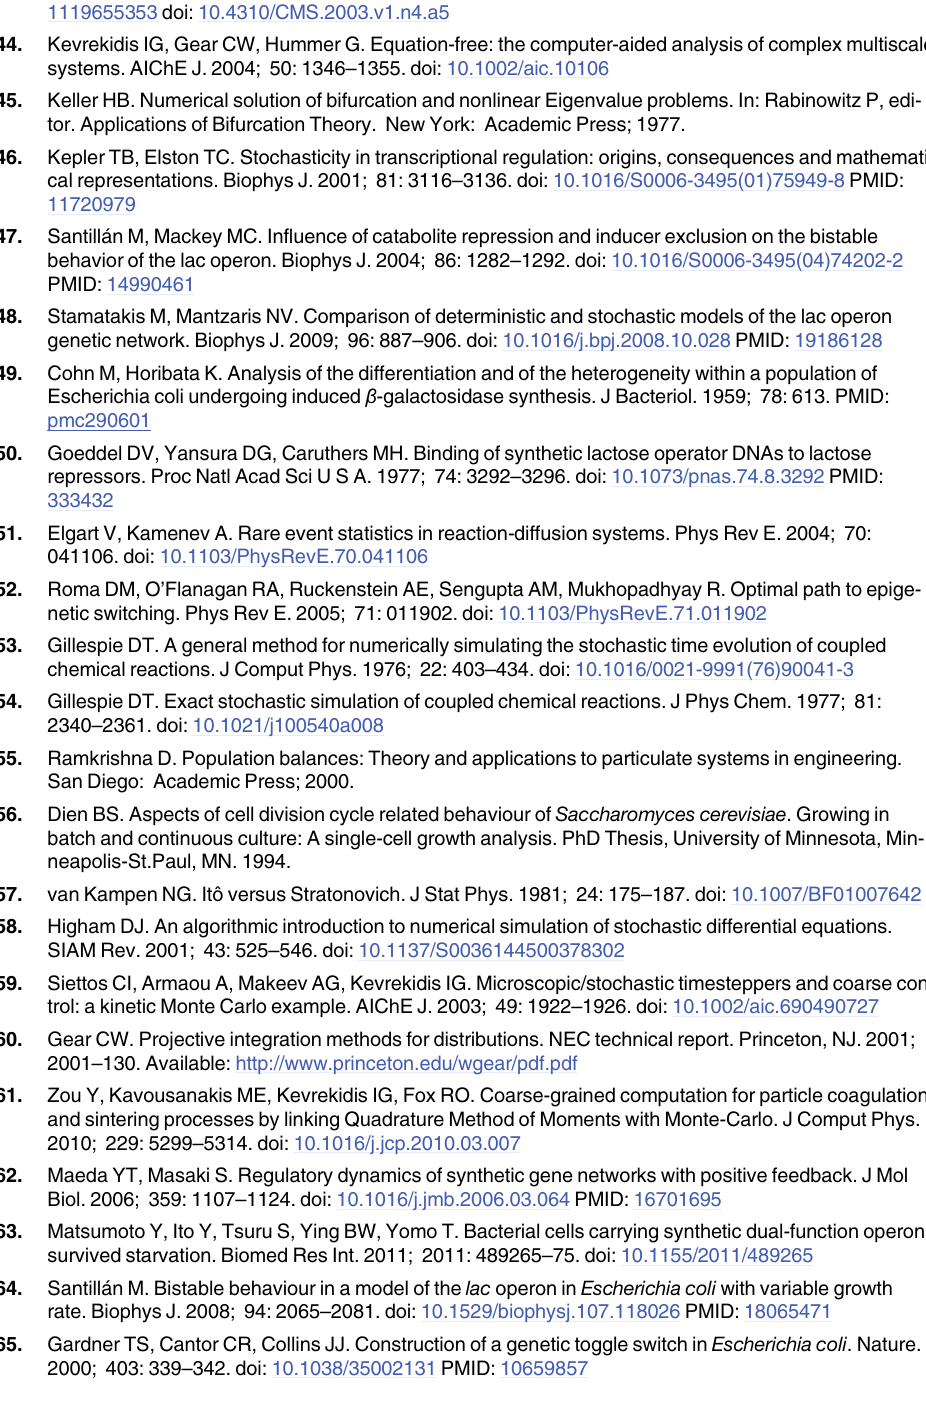
PLOS ONE | DOI:10.1371/journal.pone.0132946 July 17,